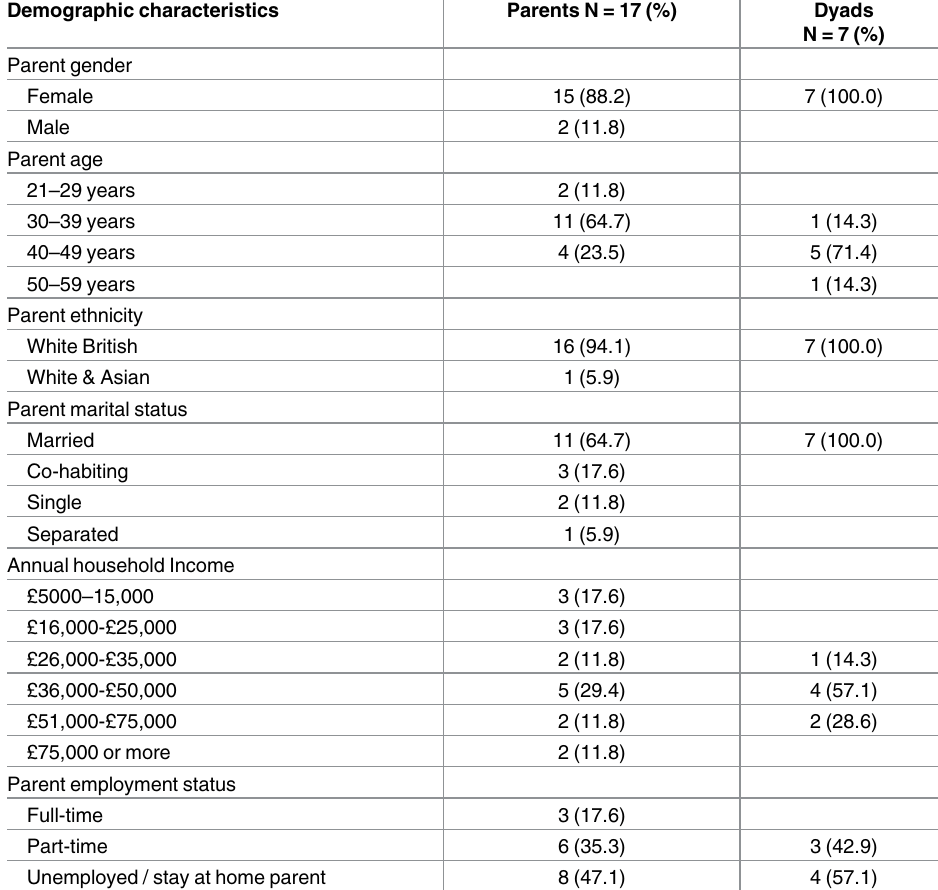
Table 2. Parent sample demographic